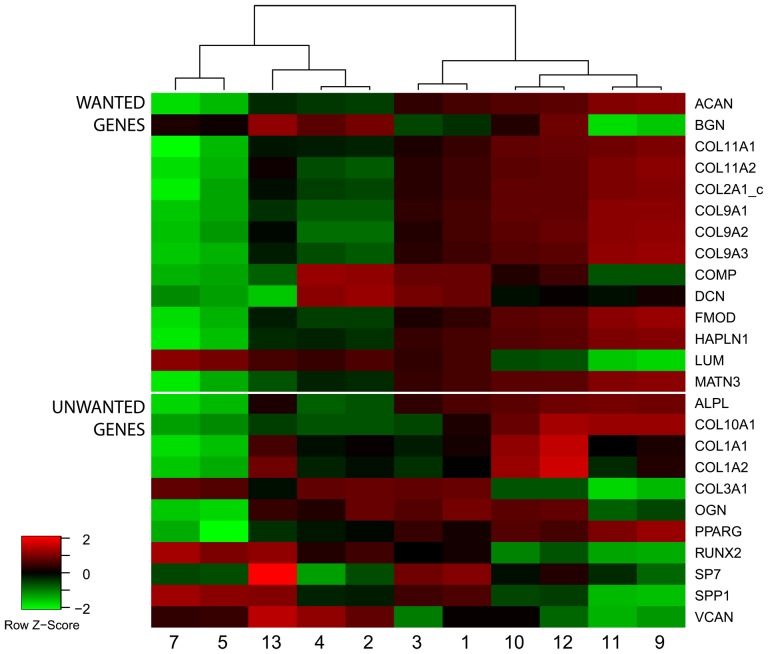
Heatmap of top ranking conditions.Heatmap of wanted and unwanted genes in all conditions significantly enriched for wanted, but not unwanted markers, color coded by the studentized score.